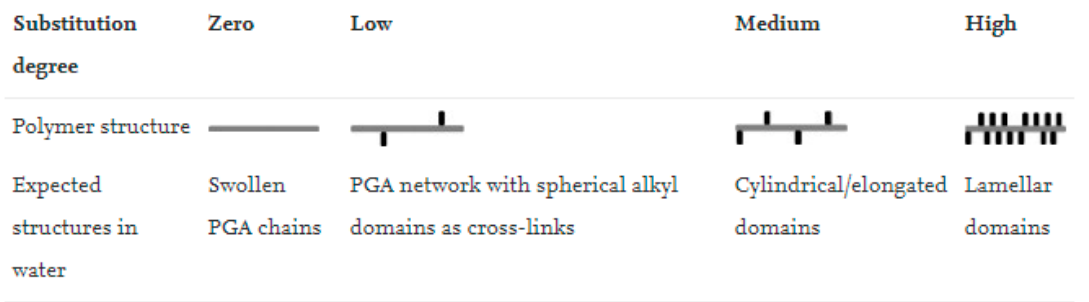
Figure 2 . Transmission electron micrographs of nanoparticles [33]. The morphology of nanoparticles produced with a range of polymers is shown here. The white scale bars indicate 100 nm. a – c : PGA- stearate 20%, stained with uranyl acetate. d : PGA-behenate 45%, stained with uranyl acetate. e + f : PGA-stearate 50%, e : Stained with uranyl acetate; f : Freeze fractured. g : PGA-stearate 65%, freeze fractured. h : PGA-behenate 65%, freeze fractured. i : PGA-stearate 85%, freeze fractured. Copyright 2012 Elsevier. The ability of bare PGA, and PGA with the polymer backbone substituted with varying amounts of pendant C 18 (stearate) and C 8 (octanoate) chain length acyl groups, to encapsulate the water soluble drug dexamethasone phosphate (DXMP) into NPs was investigated in two papers from the Garnett group [14,37]. In both papers, polymers modified with C 8 were found to give the greatest improvement in encapsulation efficiency, with the level of substitution also proving to be a key factor (Figure 3). Puri et al. noted that the level of substitution affected the release of the DXMP, with a controlled release profile observed from particles made of PGA with a 100% C 8 substitution [14,37]. An agreement with the experimental trend in encapsulation efficiency has been found for a series of acylated PGAs modelled computationally. In particular, while C 18 chains promote favorable interactions with DXMP, having too many C 18 chains decreases solubility, preventing the polymer from interacting with surrounding DXMP molecules. It was therefore clear that